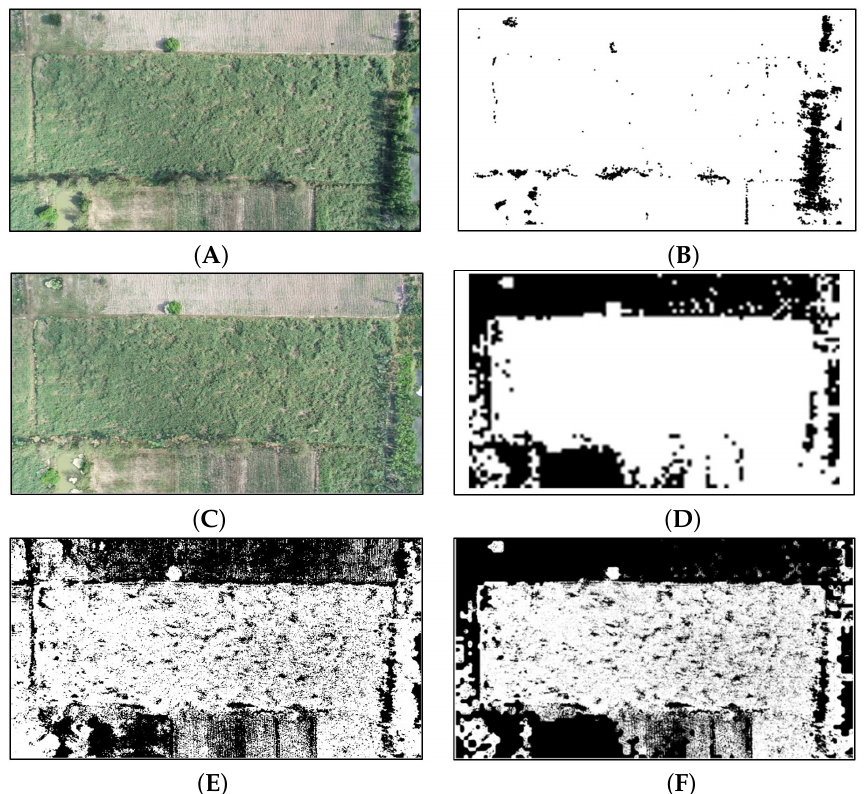
Figure 16. The result of the defect detection model. ( A ) Original image, ( B ) the result of shadow detection, ( C ) the result of shadow adjustment, ( D ) the result of sugarcane area classification, (E) the result of color selection, and ( F ) the result of defect area